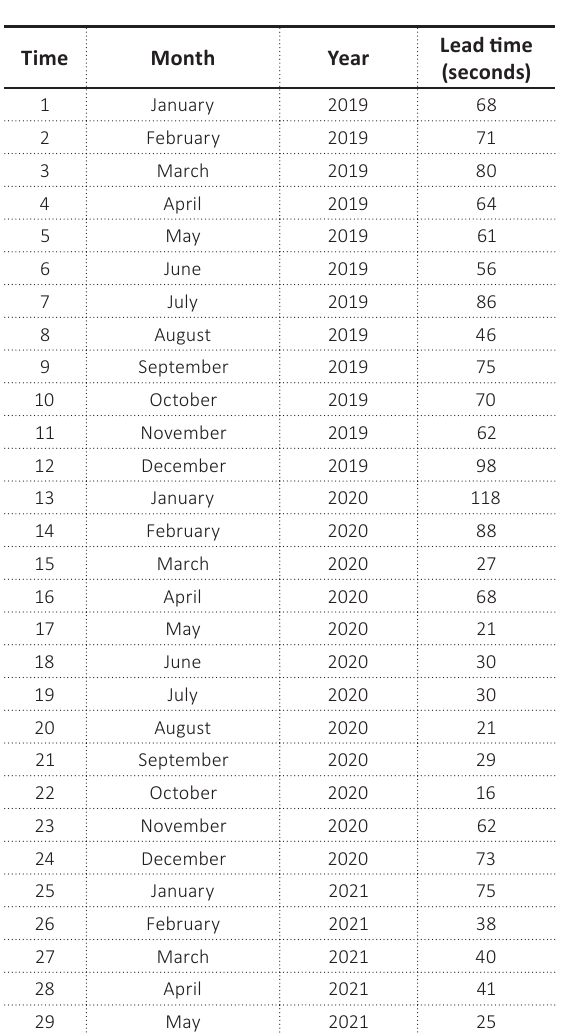
Table 2. Estimated lead time for each month